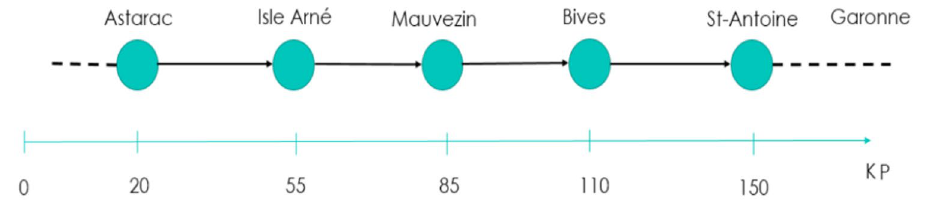
Figure 7. Synoptic of the Arrats’ river (with KP indicating the kilometric point).